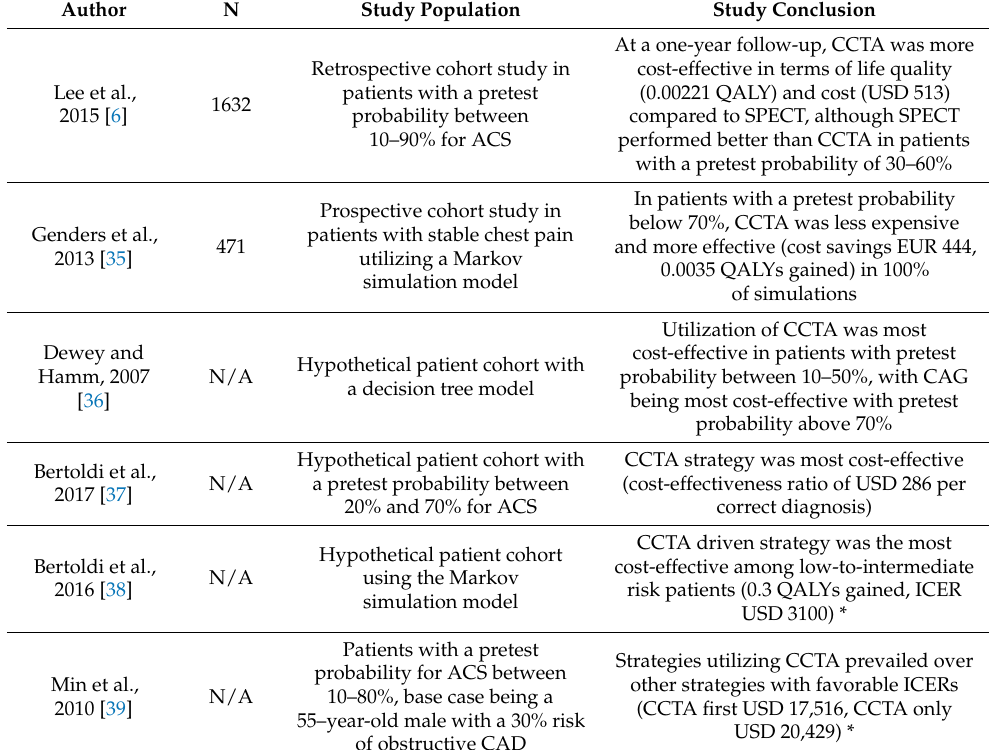
Table 2. Summary of Major Cost Effectiveness Studies for CCTA in Patients with Stable Pain